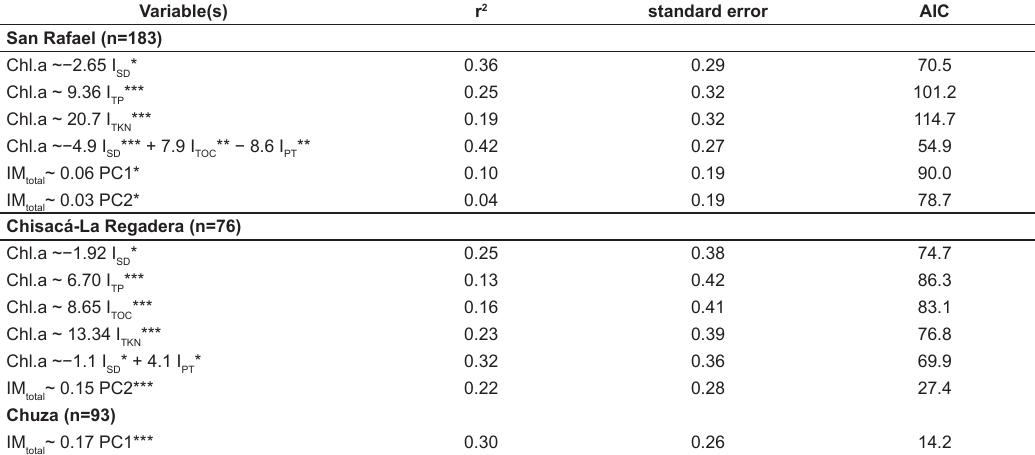
Table 8. Linear regressions used to explain chlorophyll-a and the metric index (IM